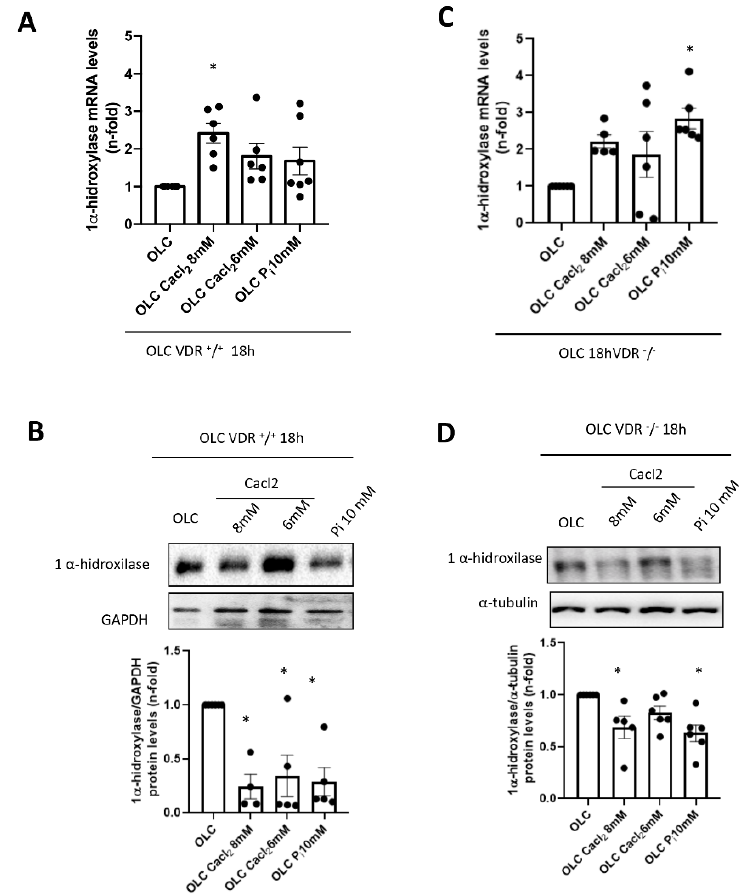
Figure 3. Study of the effects of calcium and phosphorus on the gene and protein expression of 1 α -hydroxylase. The OLCs were stimulated with different concentrations of CaCl 2 and inorganic phosphorus (P i ) (NaH 2 PO 4 + Na 2 HPO 4 ) for 18 h. ( A , C ) The gene expression of 1 α -hydroxylase